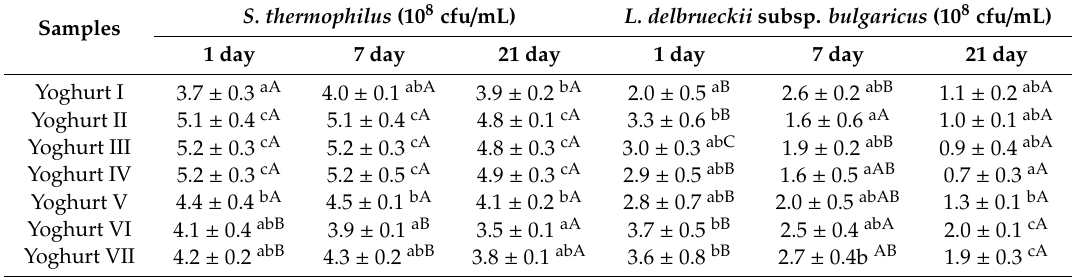
Table 4. Counting changes of two viable starter strains in Yoghurts I–VII during their storage of 21 day at 4 ◦